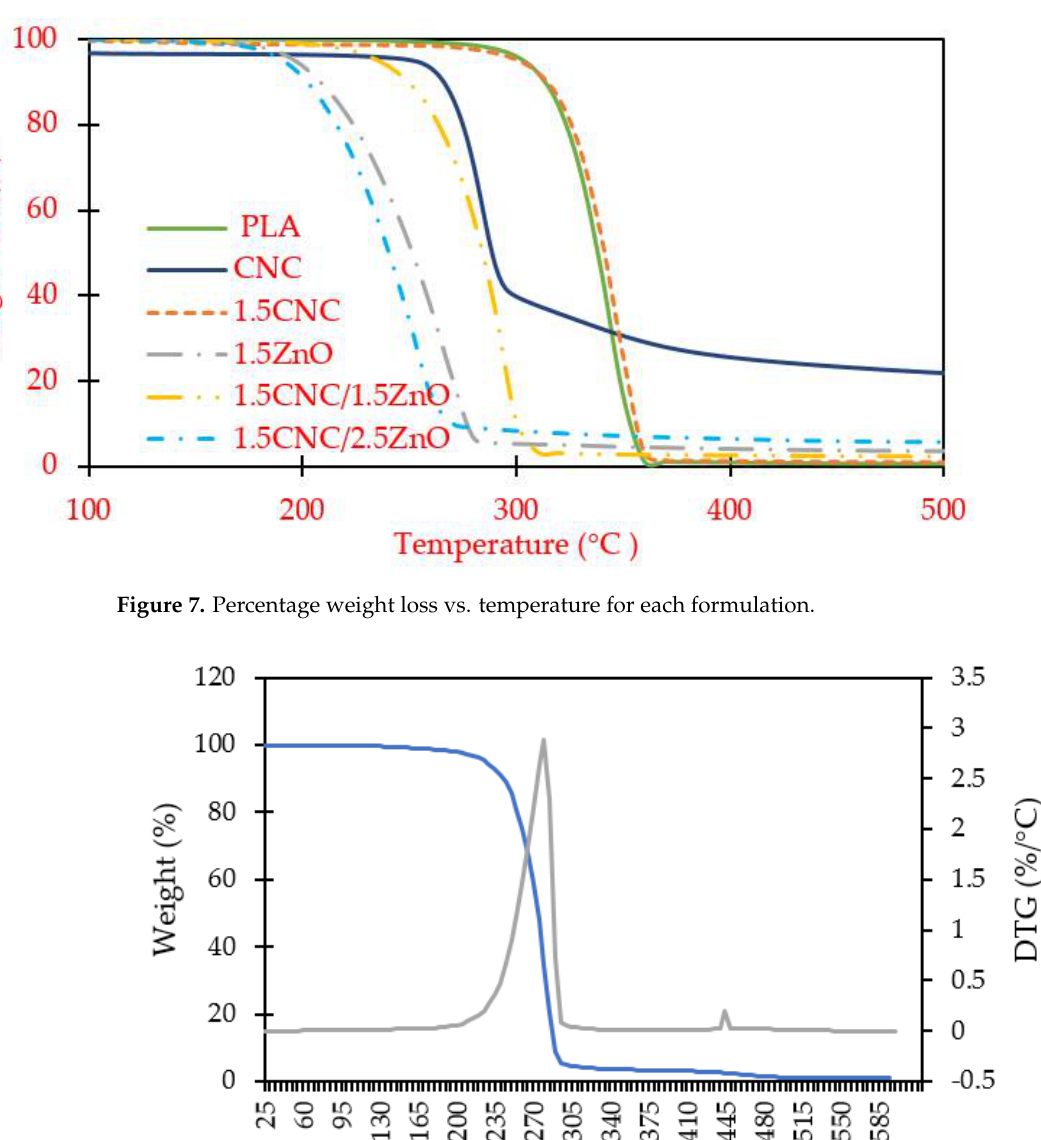
Table 3. Thermal properties of each formulation from TGA.